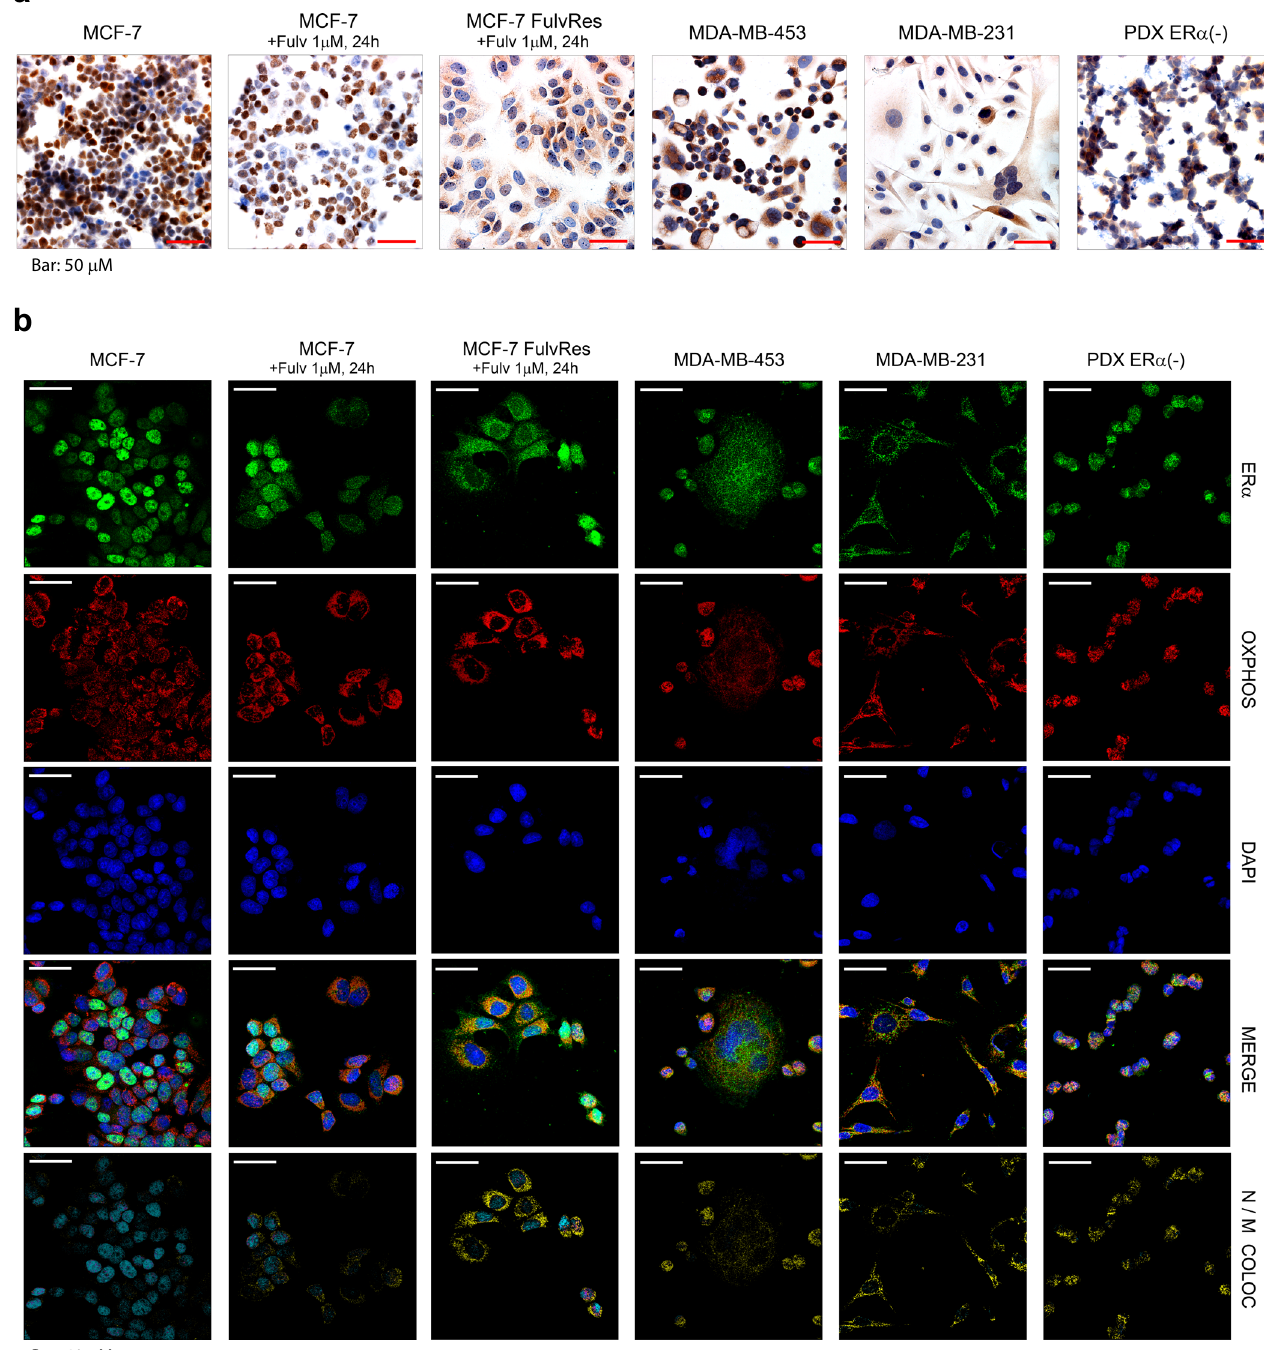
Fig. 3 ER α -LBD localizes in the cytoplasm and mitochondria of breast cancer cells. a Representative images of ER α staining by immunohistochemistry (IHC) in six different BC cell lines. All histological sections were counterstained with hematoxylin. Scale bar representing 50 μ m is shown. Magni fi cation: ×40. b Representative confocal images of BC cells stained for ER α (green), mitochondria/OXPHOS (red) and nuclei/DAPI (blue). For each cell line, merged images and colocalization images are also shown. Color code for colocalization: cyan (ER α -Nuclei, N); yellow (ER α -Mitochondria, M). A scale bar for each image representing 40 μ m is shown. Magni fi cation: ×63. tamoxifen (Supplementary Fig. 6a). Moreover, growth of MCF-7 inhibition, P > 0.0001, vs. untreated, two-way ANOVA) while ER α - FulvRes cells was signi fi cantly impaired after ER α -LDB knockdown LBDoe cells were only partially growth-inhibited (~40% inhibition, (especially under fulvestrant treatment; P > 0.0001, two-way P = 0.003, vs. untreated, two-way ANOVA), establishing a role for ANOVA) whereas no growth inhibition was observed in parental ER α -LBD in mediating endocrine resistance (Fig. 6a) that was MCF7 FulvRes cells treated with fulvestrant, compared to con fi rmed also by treating MCF-7 NC and ER α -LBDoe cells with npj Breast Cancer (2022) 96 Published in partnership with the Breast Cancer Research